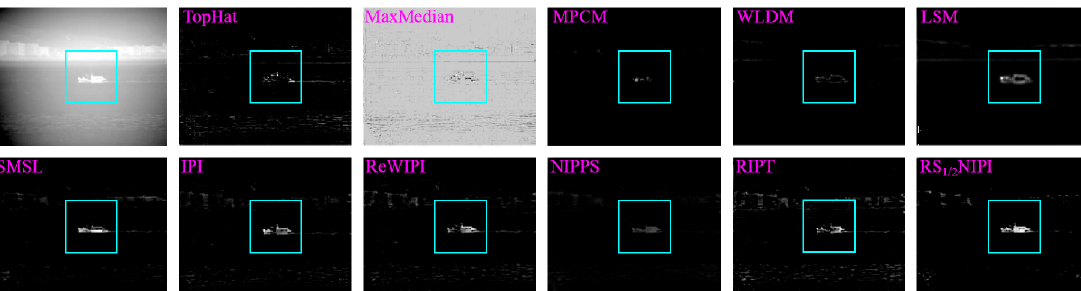
Figure 15. An example of structurally sparse target scenes and the corresponding detection results obtained by the proposed method compared with ten competitive methods.